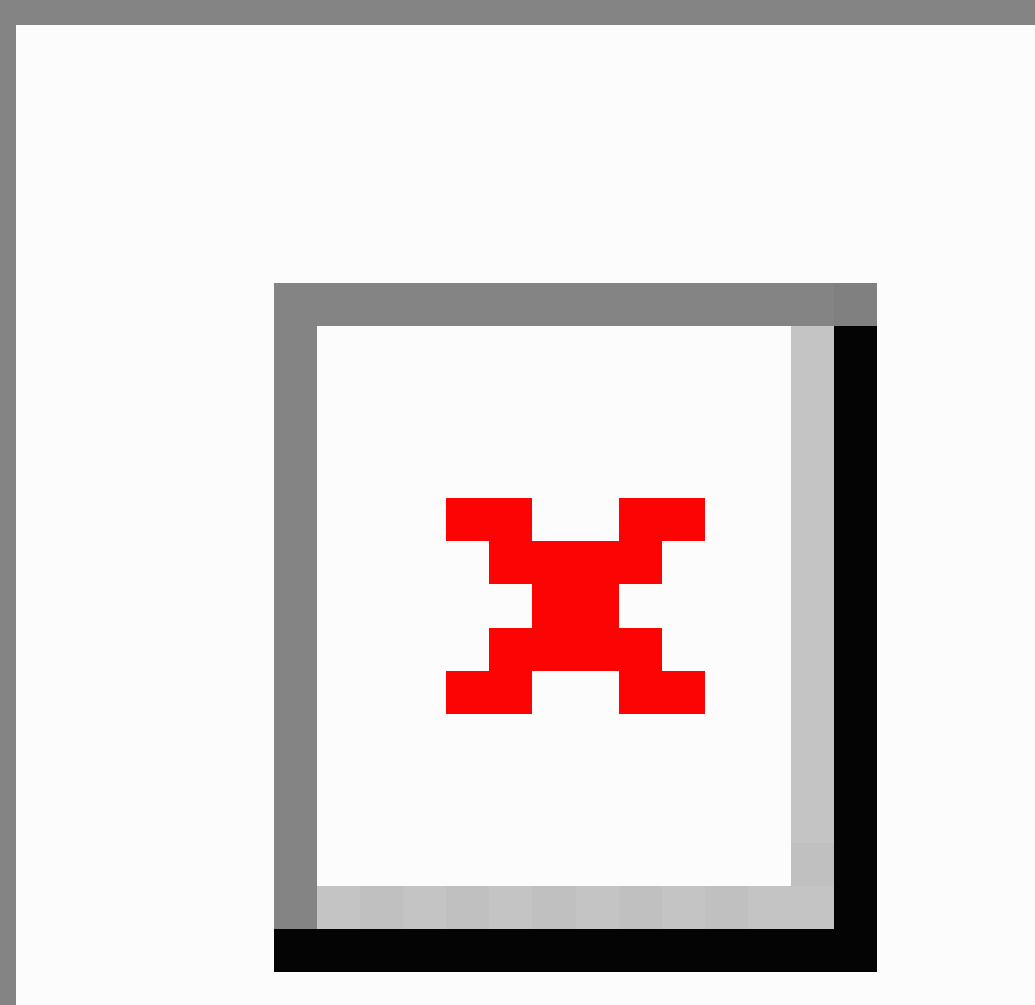
Figure 2. Screenshot and English translation of personalized feedback on the What Do You Drink